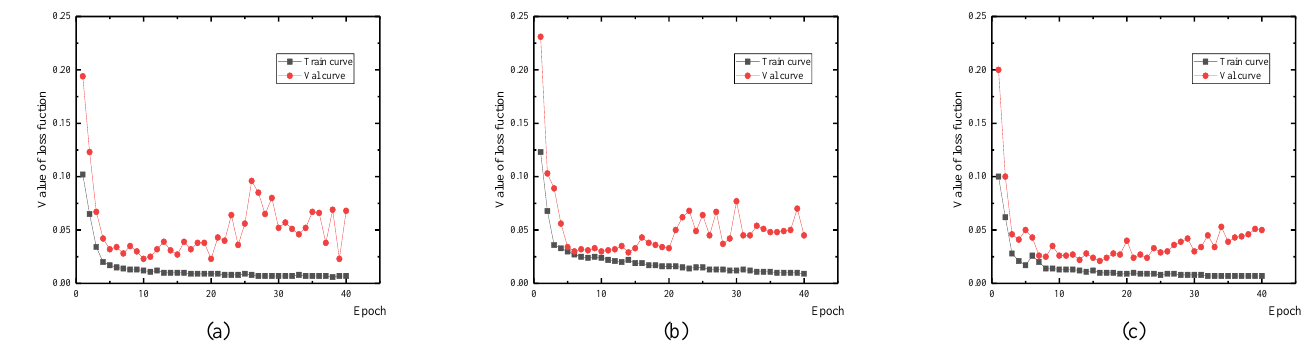
Figure 10. The learning curve of the subnetworks ( a ) IntenNet, ( b ) IDNet, and ( c ) DepthNet.